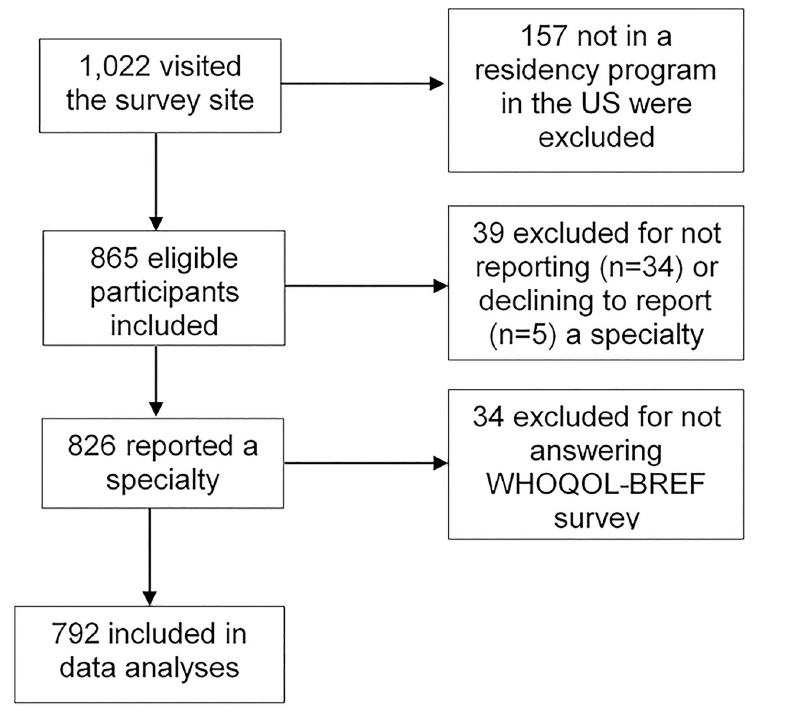
Fig 1. Flow-chart depicts the inclusions and exclusions of the study participants.